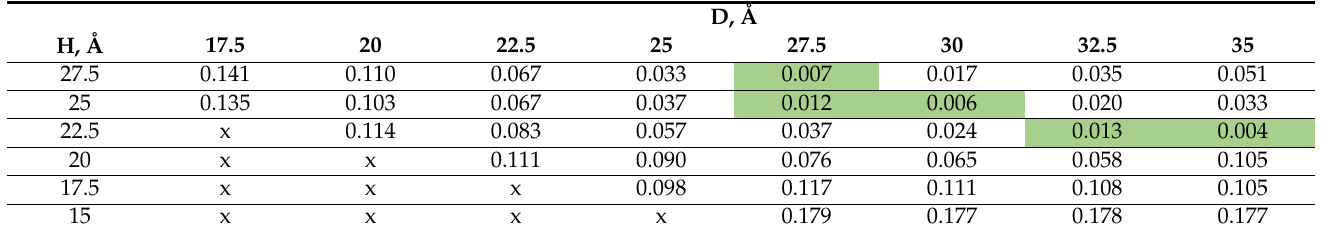
Table 3. Values of the objective function for different heights (H) and diameters (D) of cylindrical particles at the fixed fraction of Si 2 O 4 layers ( α =